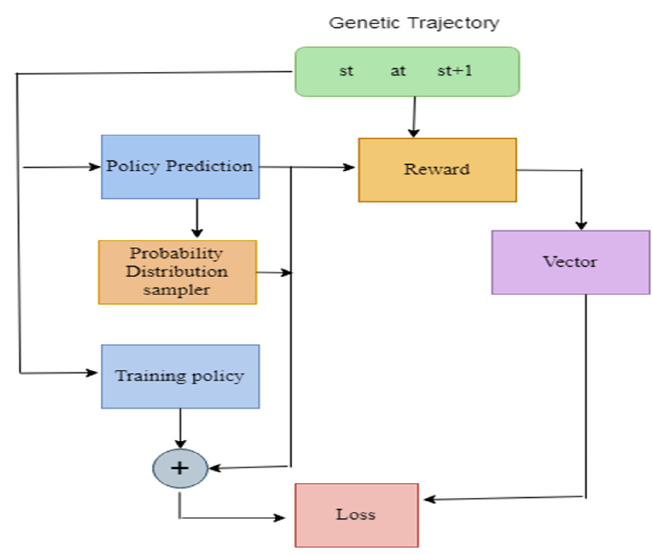
Figure 6. Framework of the Policy Gradient model .